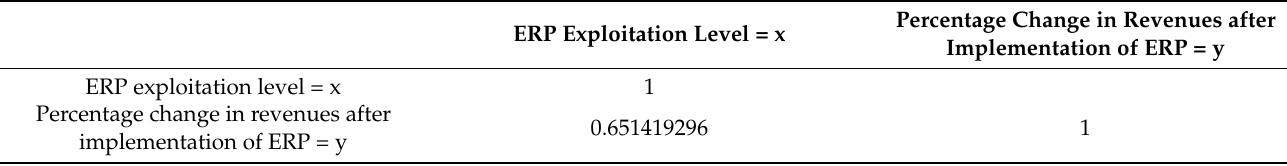
Table 5. Pearson correlation (ERP exploitation level and cost savings). ERP Exploitation Level = x